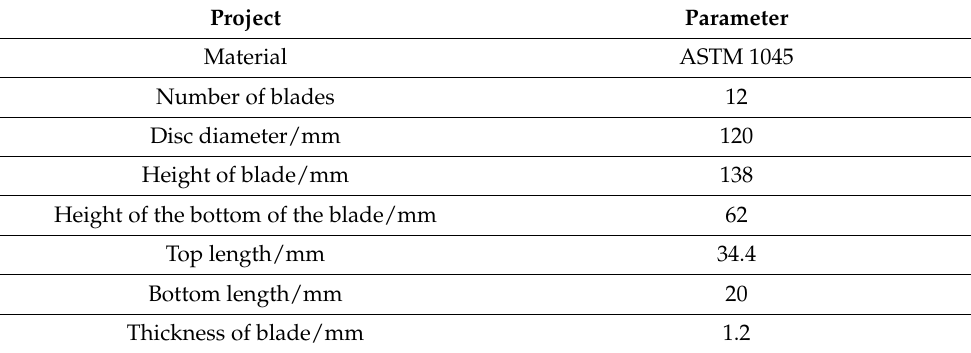
Table 1. Material and geometric parameters of the blade.